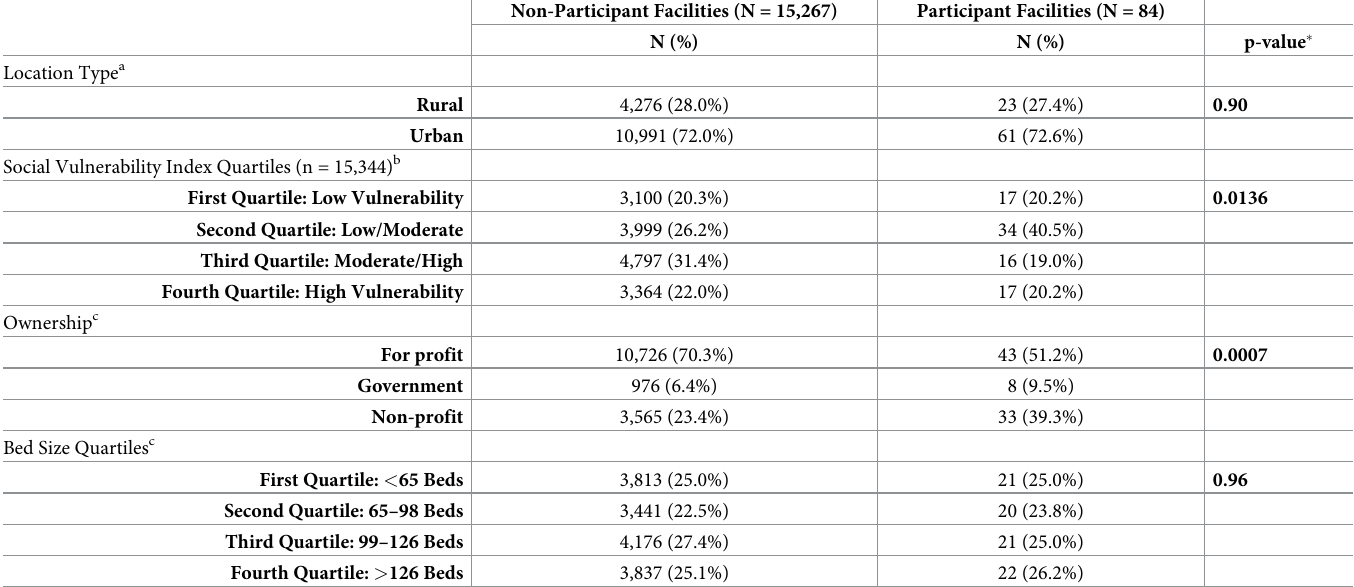
Table 1. Facility